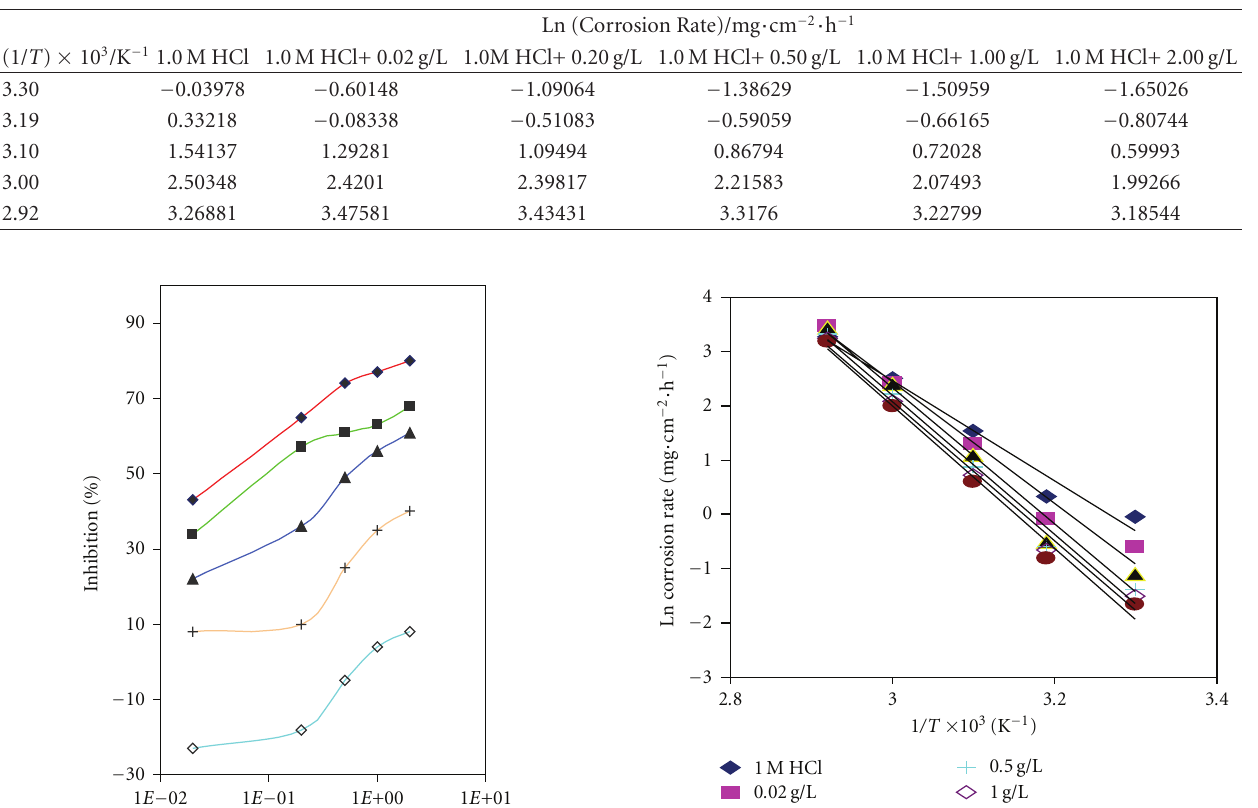
Table 4: The data obtained from the weight loss measurements for Arrhenius Equation: ( I / T ) against Ln (Corrosion Rate).